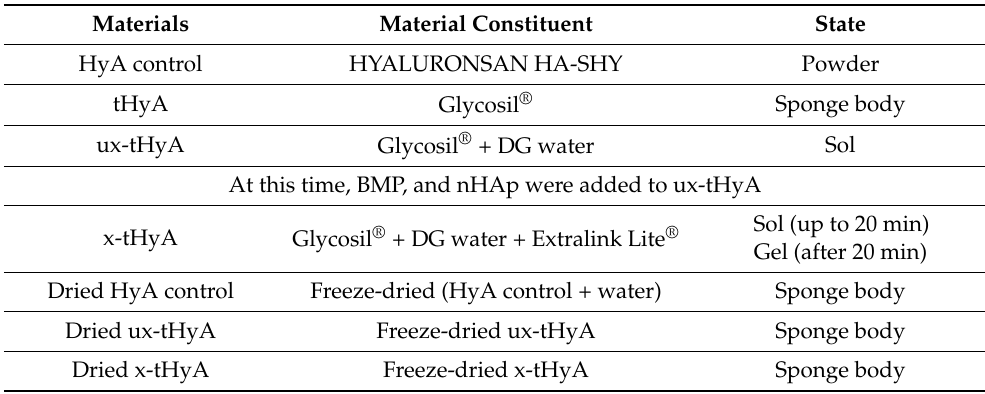
Table 2. Design of materials and experiments.